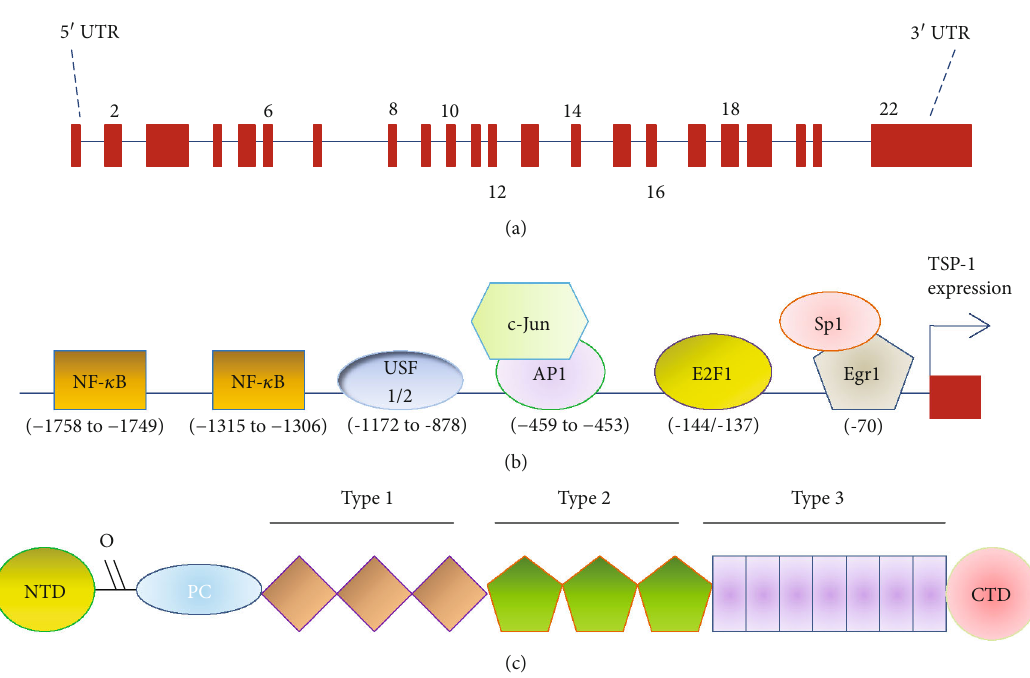
Figure 1: Schematic diagrams of the THBS1 gene and the thrombospondin-1 (TSP-1) protein. (a) Intron-exon organization of the THBS1 gene. The THBS1 gene consists of 16,393 bases including 22 exons. Exons 2-21 encode the 5729 b of mRNA. (b) Di ff erent transcription factors bind to the promoter of TSP-1 to induce its expression. USF1/2: upstream stimulatory factors 1/2; Sp1: stimulating protein; NF- κ B: nuclear factor-kappa B; Egr1: early growth response 1; and AP1: activator protein 1. (c) Domain organization of TSP-1. NTD: N-terminal domain; O: oligomerization sequence; PC: procollagen homology region; types 1, 2, and 3: the three types of repeat units; CTD: C- terminal